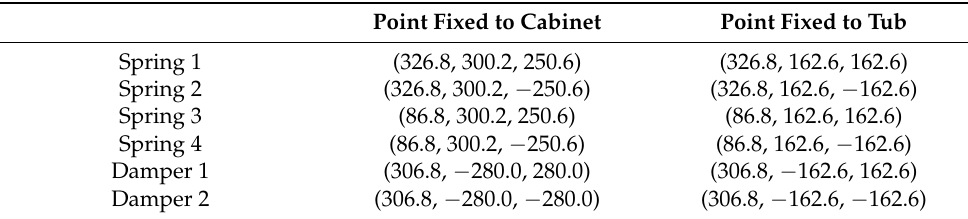
Figure 4. Spring and damper connecting the tub and cabinet. Table 4. Initial end point locations of 4 springs and 2 dampers relative to the origin.